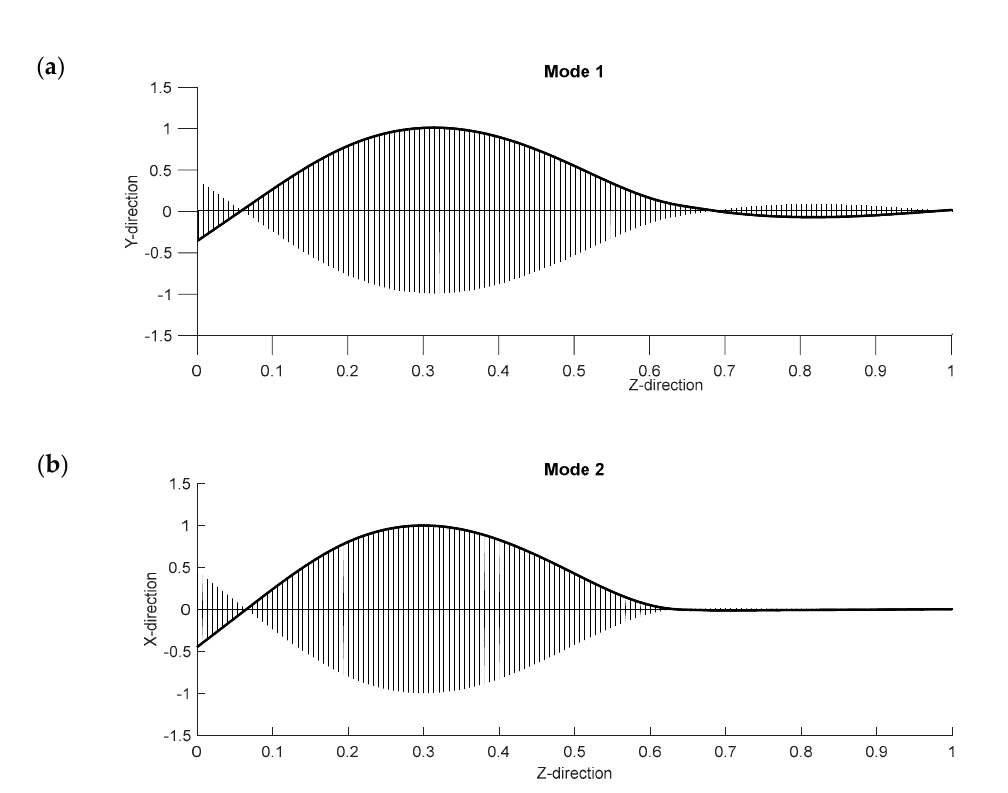
Figure 6. First and second mode shapes simulated in the FE model developed. ( a ) First natural frequency 50.66 Hz; dom- inant in the Y-direction. ( b ) Second natural frequency 56.76 Hz; dominant in the X-direction.